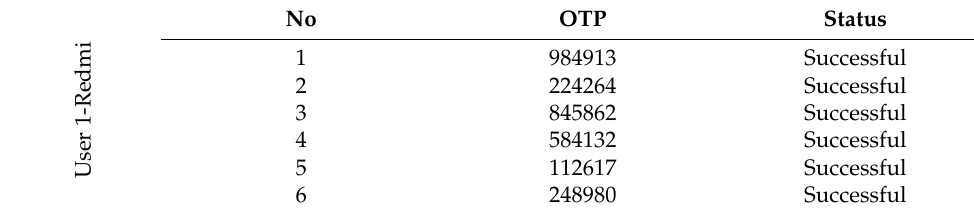
Table 3. The OTP results of the Redmi user.